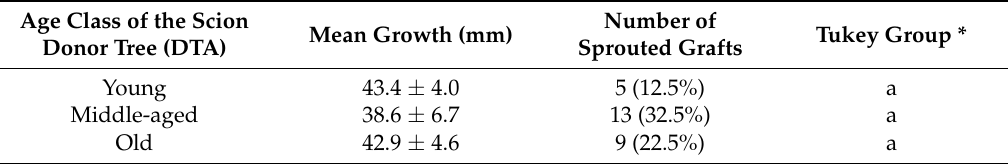
Table 11. Mean value and standard error of sprouted graft growth, six months after grafting, by age group of scion donor trees (DTA).